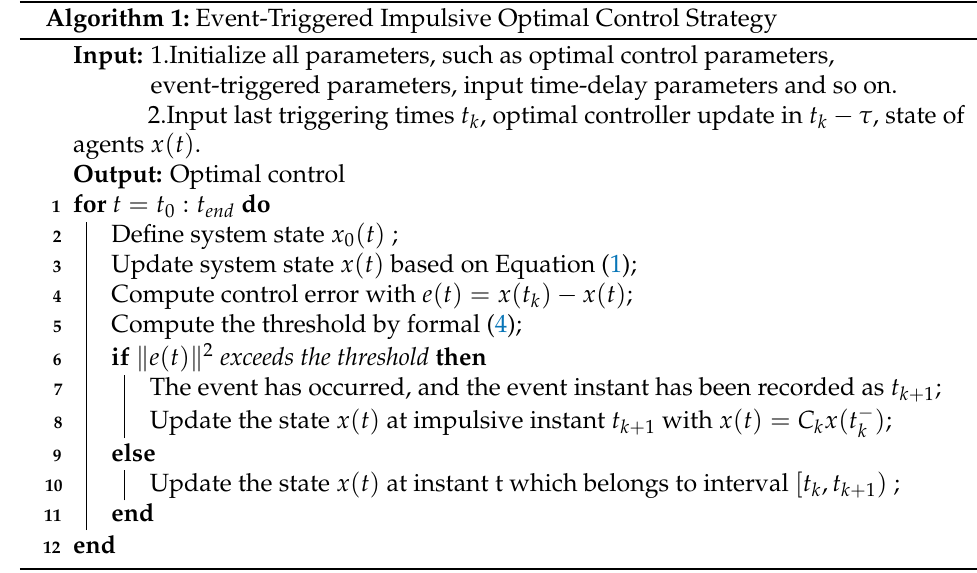
Algorithm 1: Event-Triggered Impulsive Optimal Control